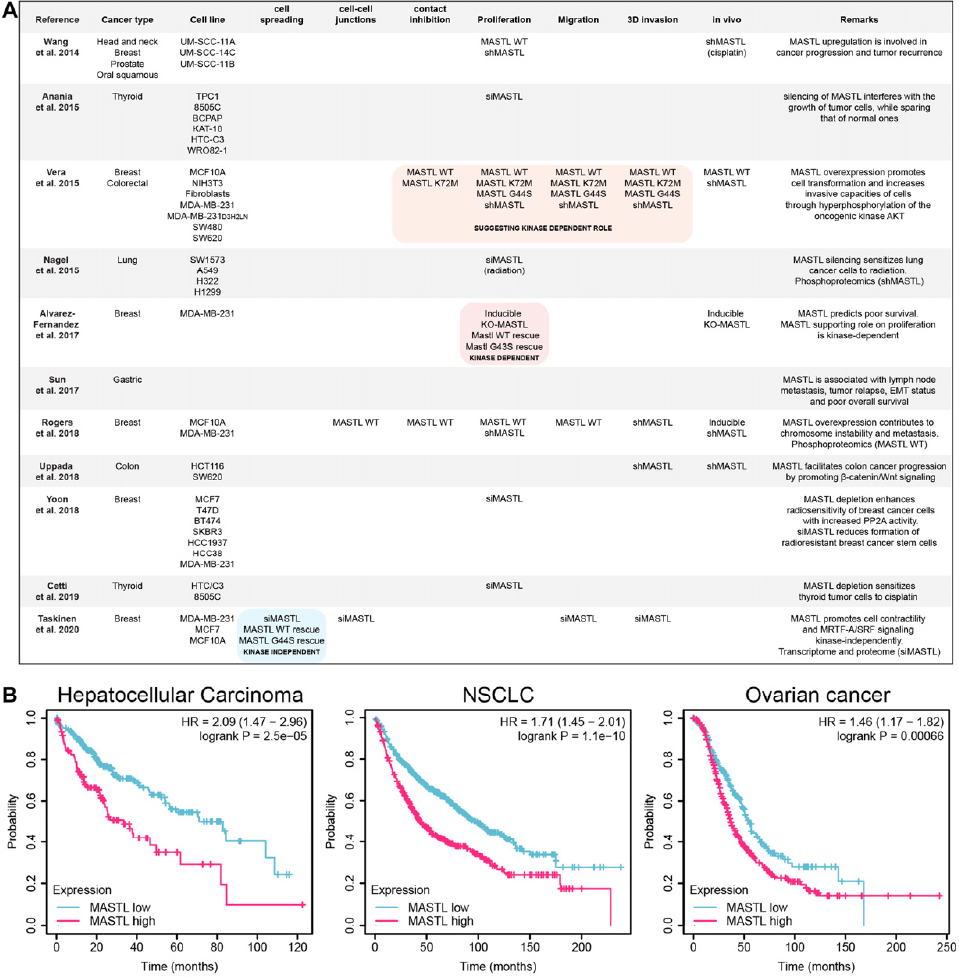
3 of 11 Figure 2. Illustration of known MASTL functions. The divisions between kinase-dependent and - independent functions are suggestive and need to be studied further. 2. MASTL in Cancer Cancer is responsible for the highest disease burden globally [9], and MASTL is implicated as a poor prognostic factor in several of the most lethal cancer subtypes, including breast [10,11], gastric [12], colon [13], liver, non-small-cell lung cancer (NSCLC), and ovarian (Figure 3). The roles of MASTL in cancer are many and various, where multiple studies have reported that silencing decreases cell proliferation, migration, and invasion, while overexpression can enhance these